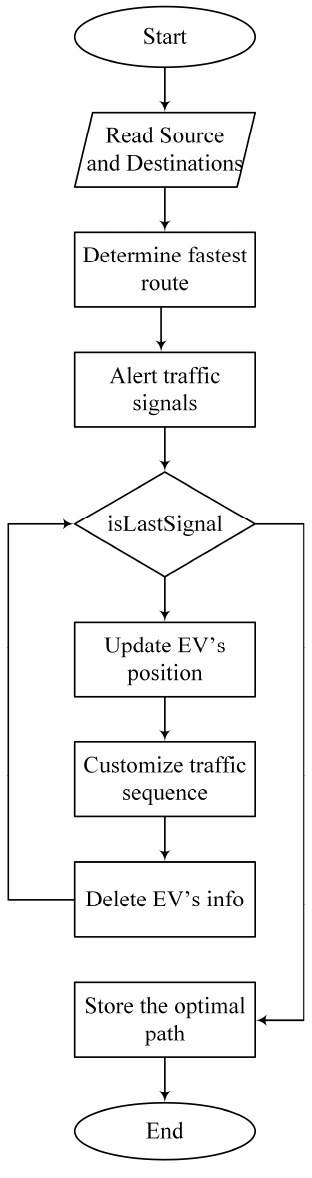
Figure 2. Flow chart for enhancing the alert system for emergency vehicles in the J2H approach. Algorithm 2 is used for customizing traffic signals based on the position of the EV.